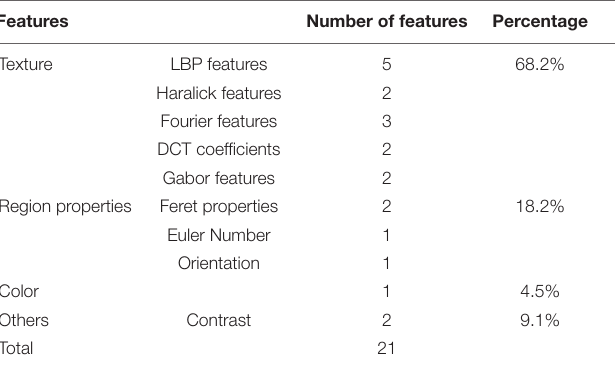
TABLE 5 | Selected features for classification of plant stress